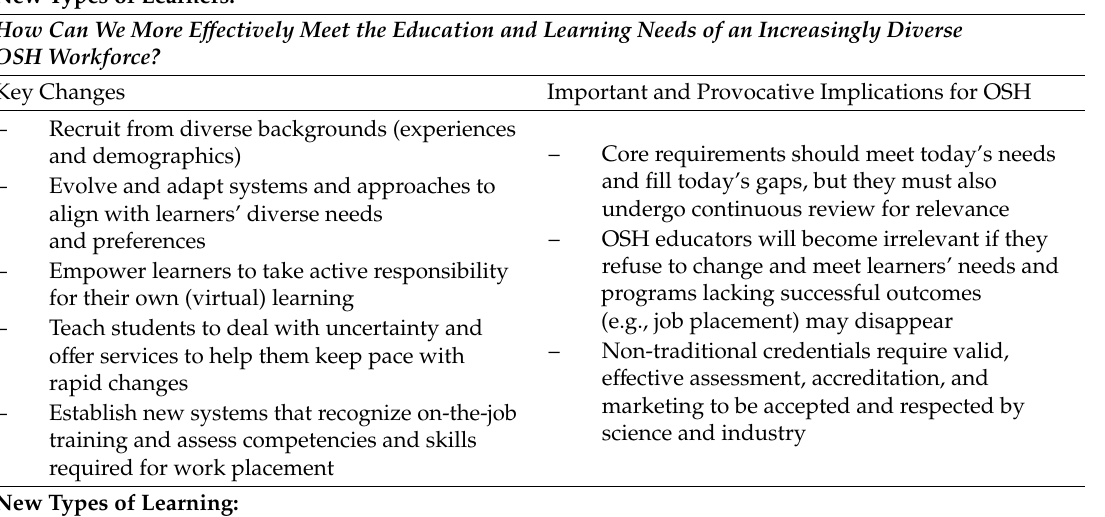
Table 1. Key changes in education and learning